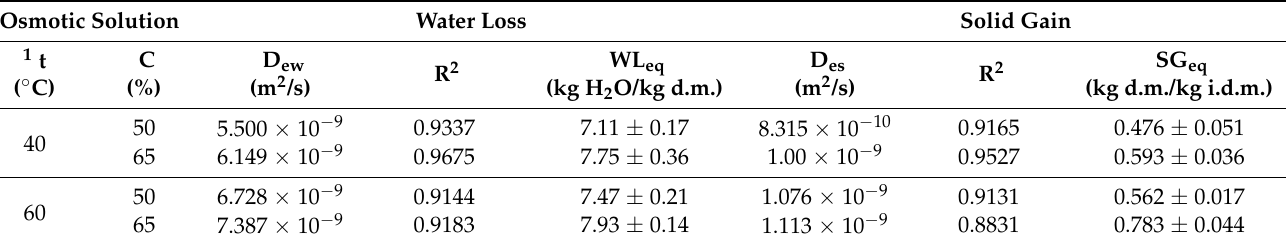
Table 4. Water and solute diffusivities during osmotic dehydration calculated by Fick ´ s model. Osmotic Solution Water Loss Solid